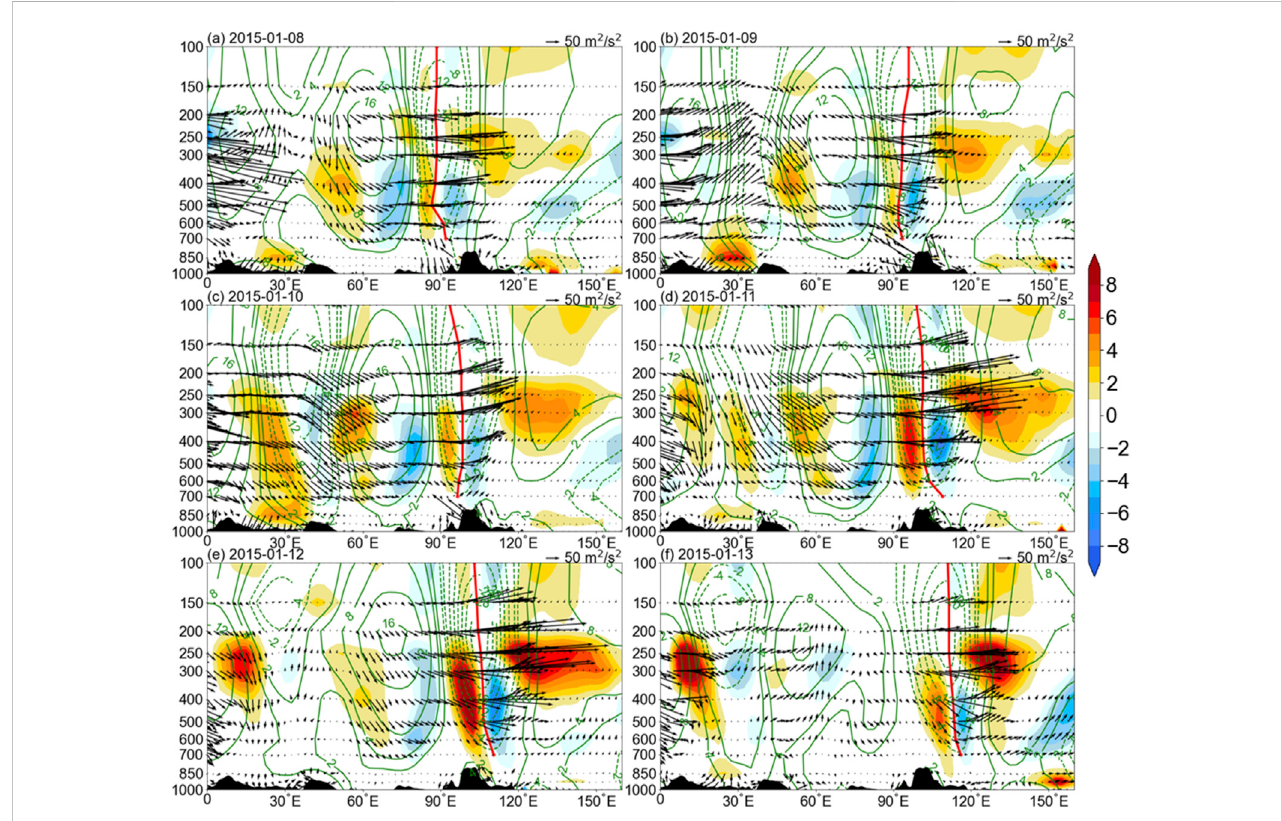
FIGURE 14 The term S B for the potential energy conversion (shading; units: 10 – 3 m 2 · s − 3 ), the wave activity fl ux (vectors; units: m 2 · s − 2 ) and the geopotential height anomalies(contours;units:10 gpm)alongthesubtropicalwesterlyjetstreamaxisat25 ° NonJanuary (A) 8, (B) 9, (C) 10, (D) 11, (E) 12and (F) 13in2015.Thered line shows the vertical trough line with the maximum DH value in each layer. The black shading shows the shape of the